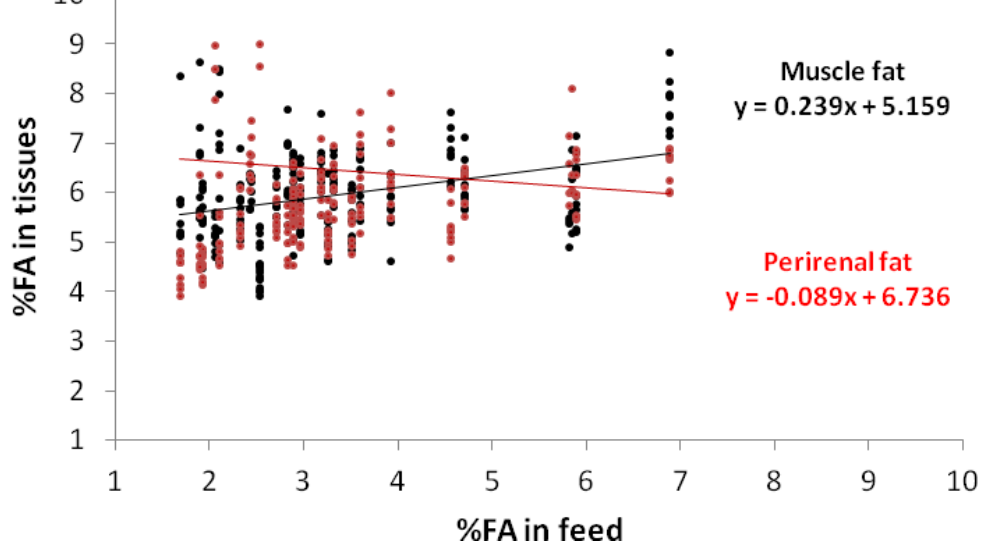
Figure 3. Regressions of the stearic acid (C18:0) contents in the muscle fat and perirenal fat, according to their contents in the feed.